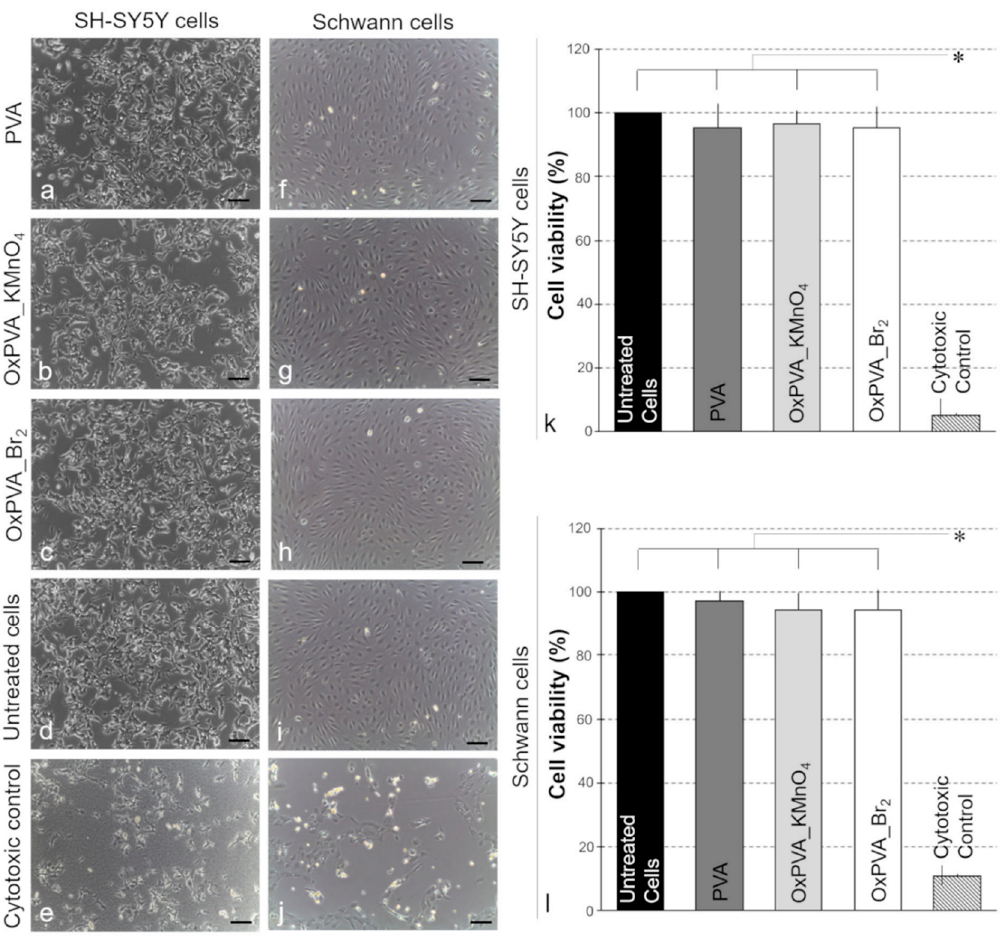
Figure 5. Cytotoxicity test. ( a – j ) Morphological analysis by optical microscopy of SH-SY5Y ( a – e ) and Schwann cell ( f – j ) cultures after treatment with native and oxidized PVA-conditioned media. ( k , l ) Cell viability of SH-SY5Y ( k ) and Schwann cell ( l ) cultures after treatment with native and oxidized PVA-conditioned media. Data are the average of three different experiments ± standard deviation and results are presented as percentage of living cells compared to the untreated control (*: p < 0.01). Scale bars: 100 µm.